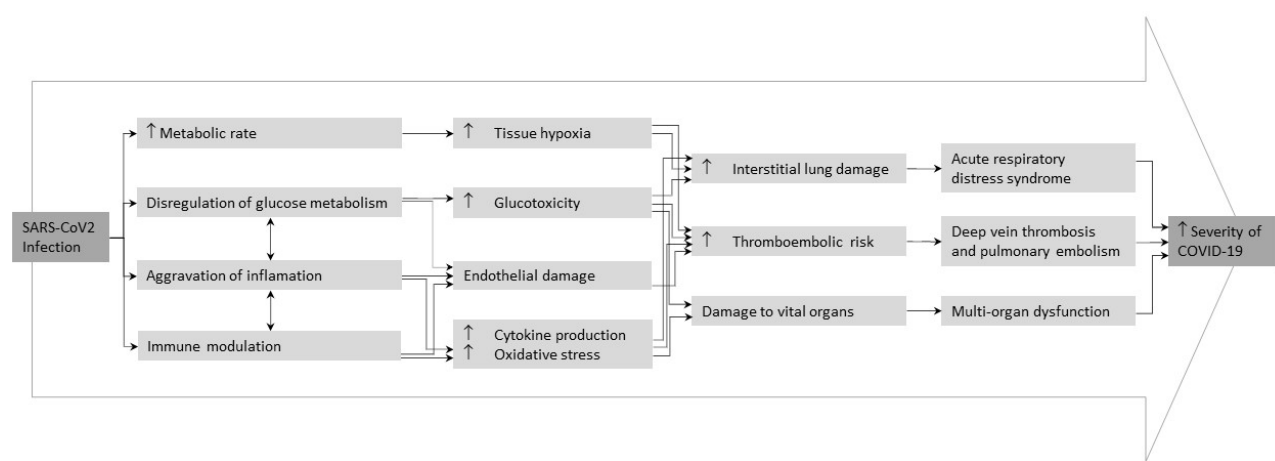
Figure 2. Possible mechanisms behind adverse clinical outcomes of COVID-19 in people with type 2 diabetes mellitus. Adapted from Lim et al. [ Error! Bookmark not defined. ].